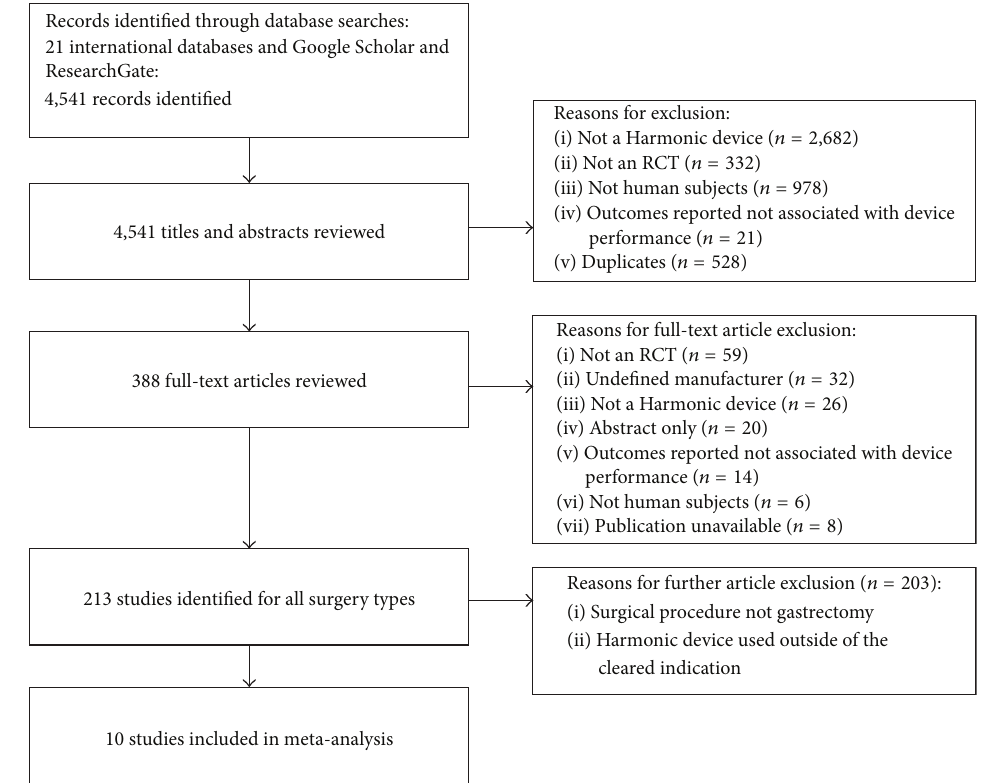
Figure 1: PRISMA diagram for the systematic literature